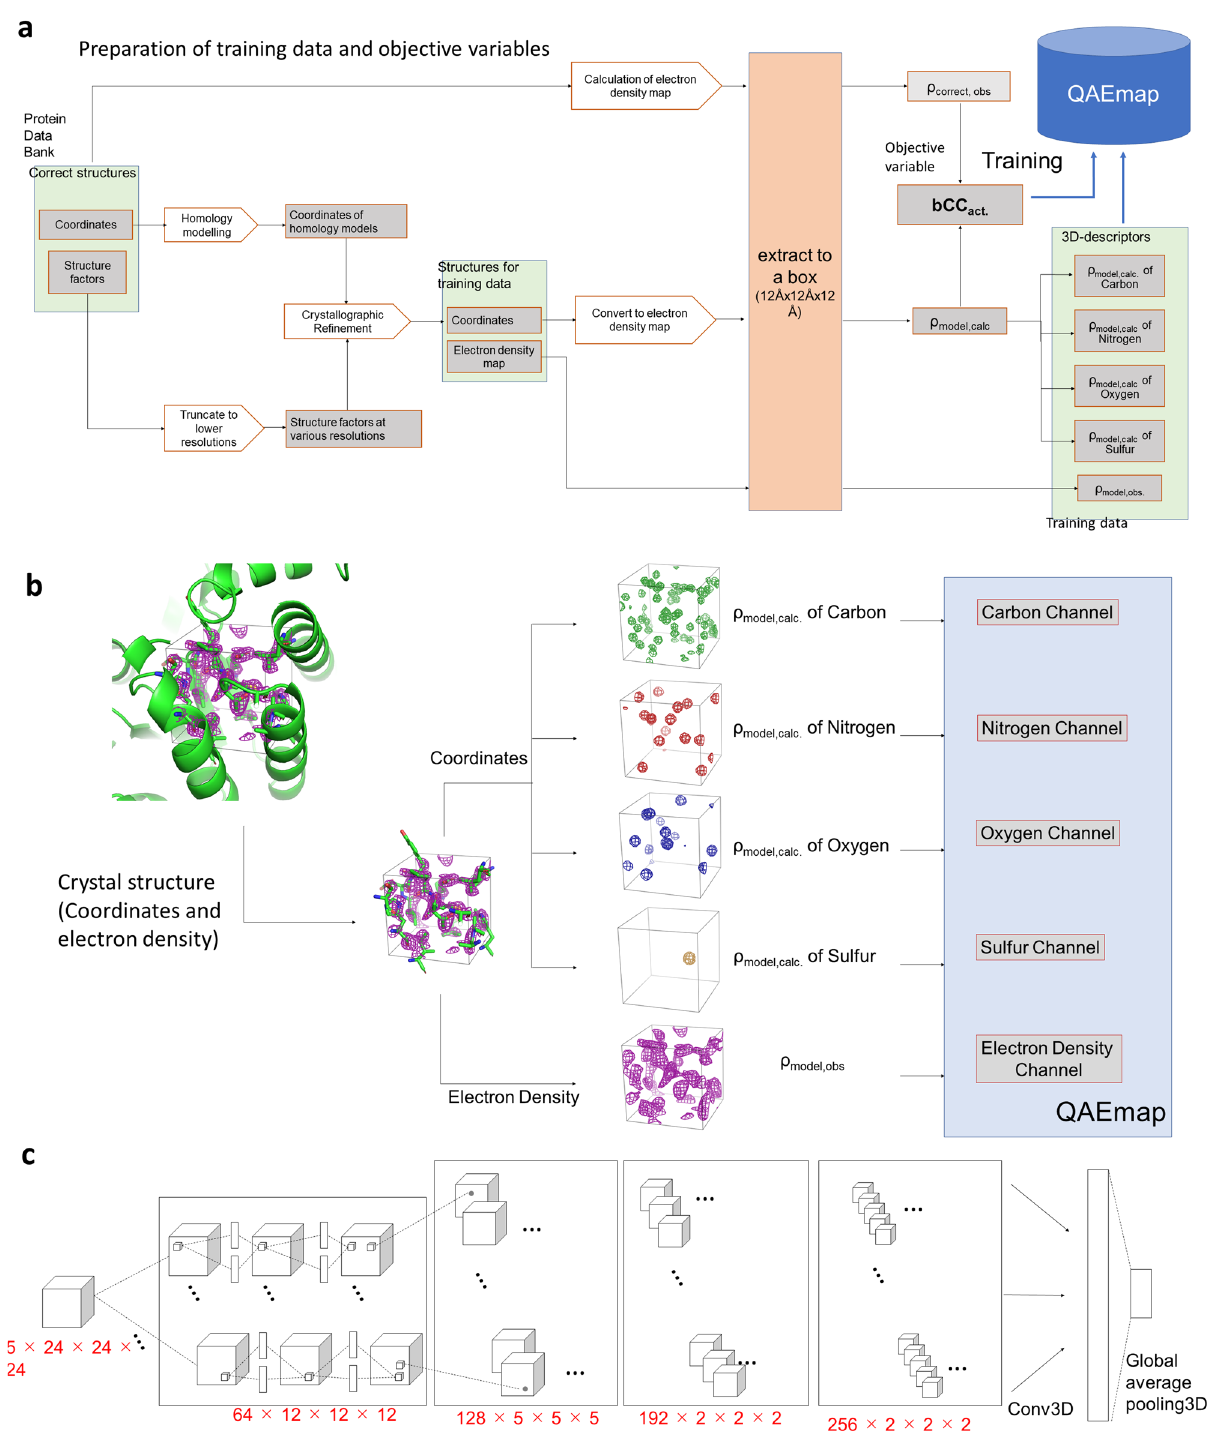
Figure 4. Overview of QAEmap. ( a ) Procedure to generate input data for training. Details are provided in the “Methods” section. ( b ) Examples of three-dimensional descriptors for an amino acid. Five descriptors for each amino acid are prepared as input data. ( c ) Overview of QAEmap architecture for learning one amino acid type. It consists of four convolutional neural network (CNN) layers followed by the maximum pooling or average, and the dropout that was inserted before the last convolution layer. Twenty identical learning models were prepared for twenty amino acid